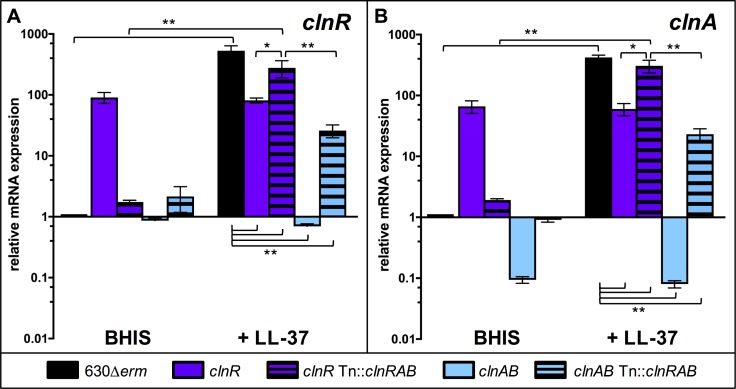
ClnR acts as a conditional repressor and inducer of clnRAB expression.Cultures of 630Δerm, clnR (MC885), clnR Tn::clnRAB (MC950), clnAB (MC935), and clnAB Tn::clnRAB (MC953) were grown in BHIS alone or BHIS with 2 μg/ml LL-37. RNA samples were collected and processed for qRT-PCR analysis as described in Methods. Graphs show the mean mRNA expression levels of A) clnR and B) clnA relative to expression in strain 630Δerm in BHIS alone. Error bars represent the standard error of the mean from at least three independent experiments. Data were analyzed by two-way ANOVA and Tukey’s multiple comparisons test, with comparisons indicated by brackets. * indicates p < 0.05, ** indicates p ≤ 0.0001.